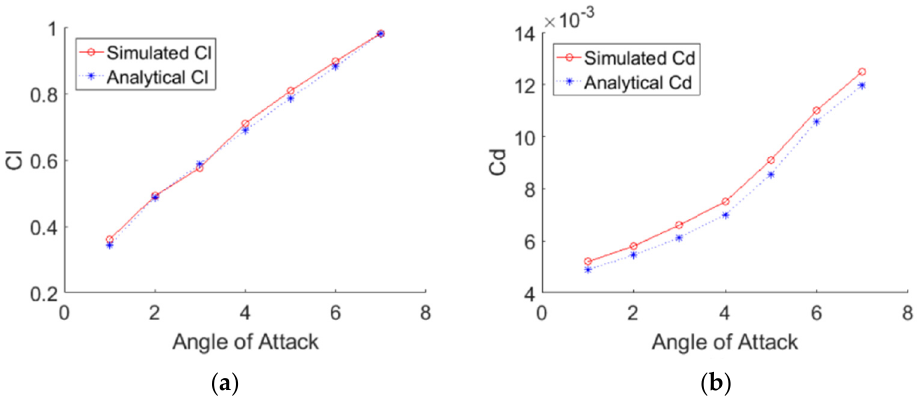
Figure 6. ( a ) 𝐶 (cid:3013) and ( b ) 𝐶 (cid:3005) vs. varying AoA. The pressure and velocity distribution show changes that travel far away from the wall, as shown in Figures 7 and 8. The fluid domain that reaches up to 8 to 10 chord lengths seems large enough to capture the detail flows.